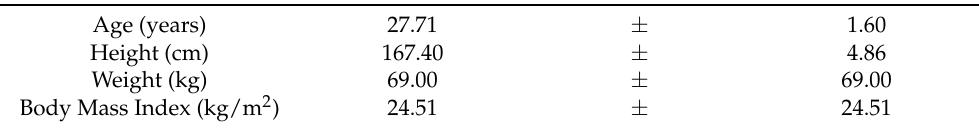
Table 1. Anthropometric characteristics of the study population presented as mean ± standard deviation.